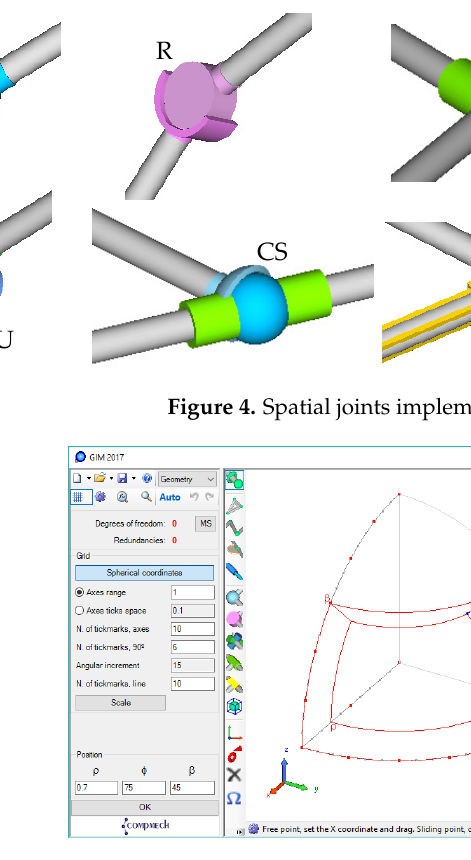
Figure 3. Planar joints implemented in GIM.